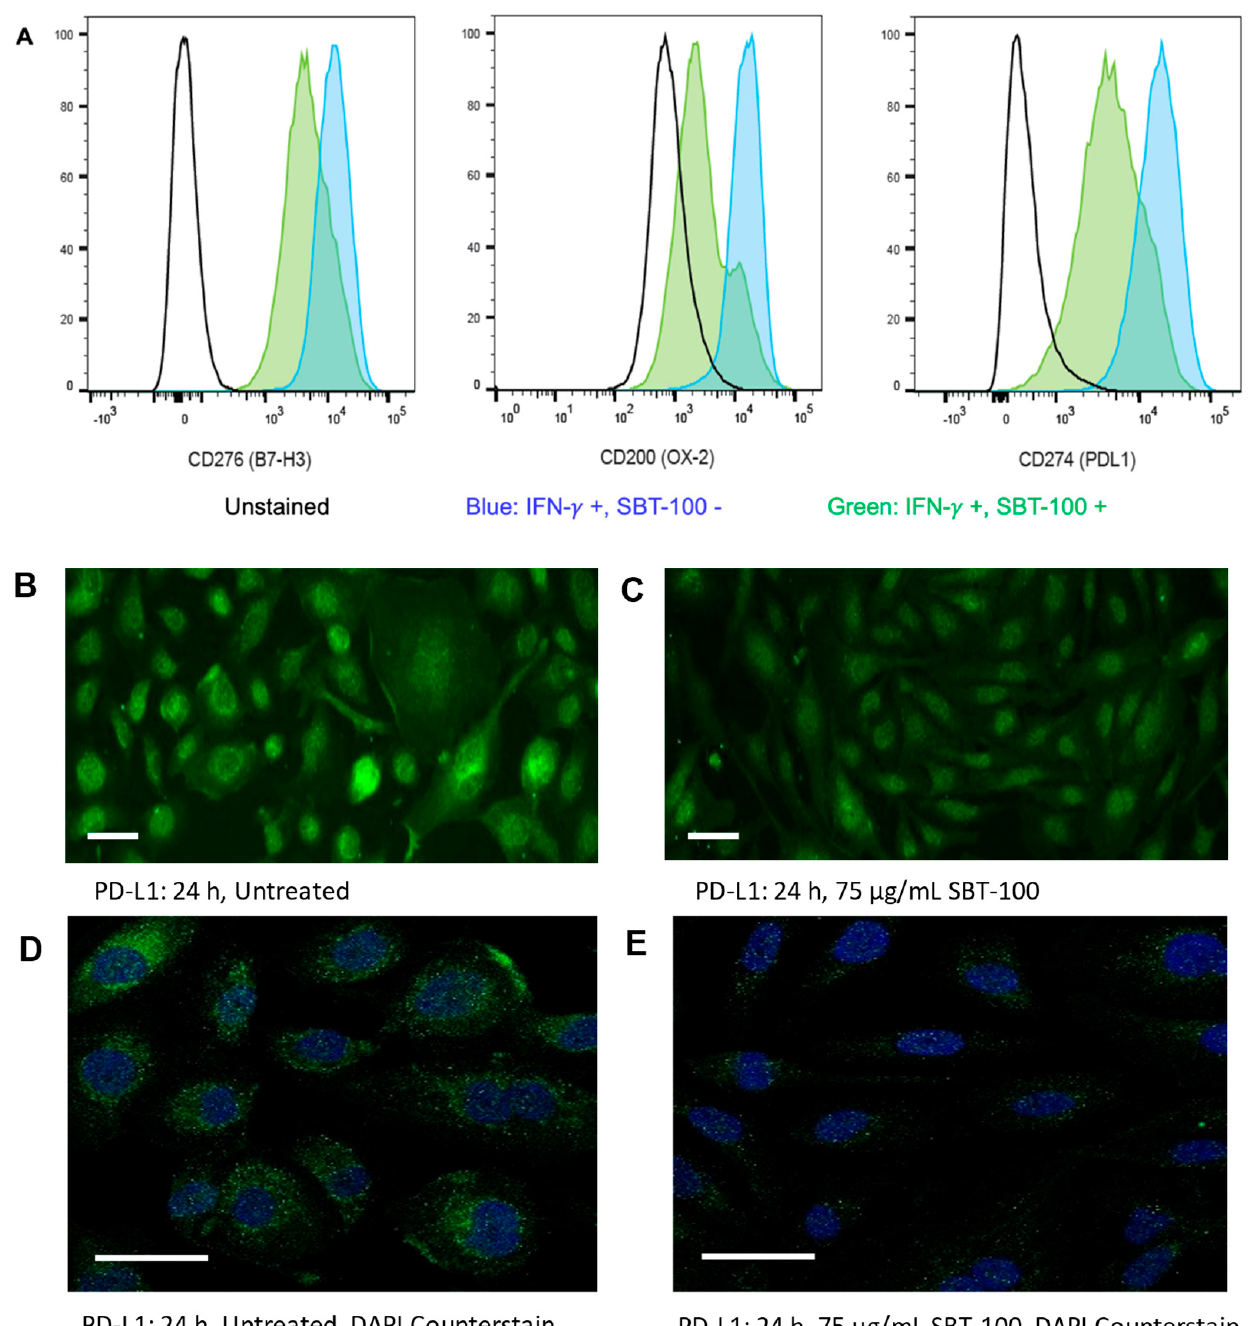
Figure 3. SBT-100 decreases the expression of immune checkpoint inhibitors in various cancer cell lines. ( A ) Surface expression of checkpoint inhibitors, B7-H3, OX-2, and PD-L1, was determined by flow cytometry in SJSA-1 osteosarcoma cells in the presence or absence of SBT-100, upon stimulation with IFN- γ (75 µ g/mL). Fluorescent microscopy of PD-L1 expression in MDA-MB-231 cells without SBT-100 ( B ) and with SBT-100 ( C ). Confocal fluorescent microscopy of PD-L1 expression in MDA-MB-231 cells without SBT-100 ( D ) and with SBT-100 ( E ), both with the nuclei detection with DAPI. The scale bars in the lower-left corner of panels ( B – E ) represent 50 µm.